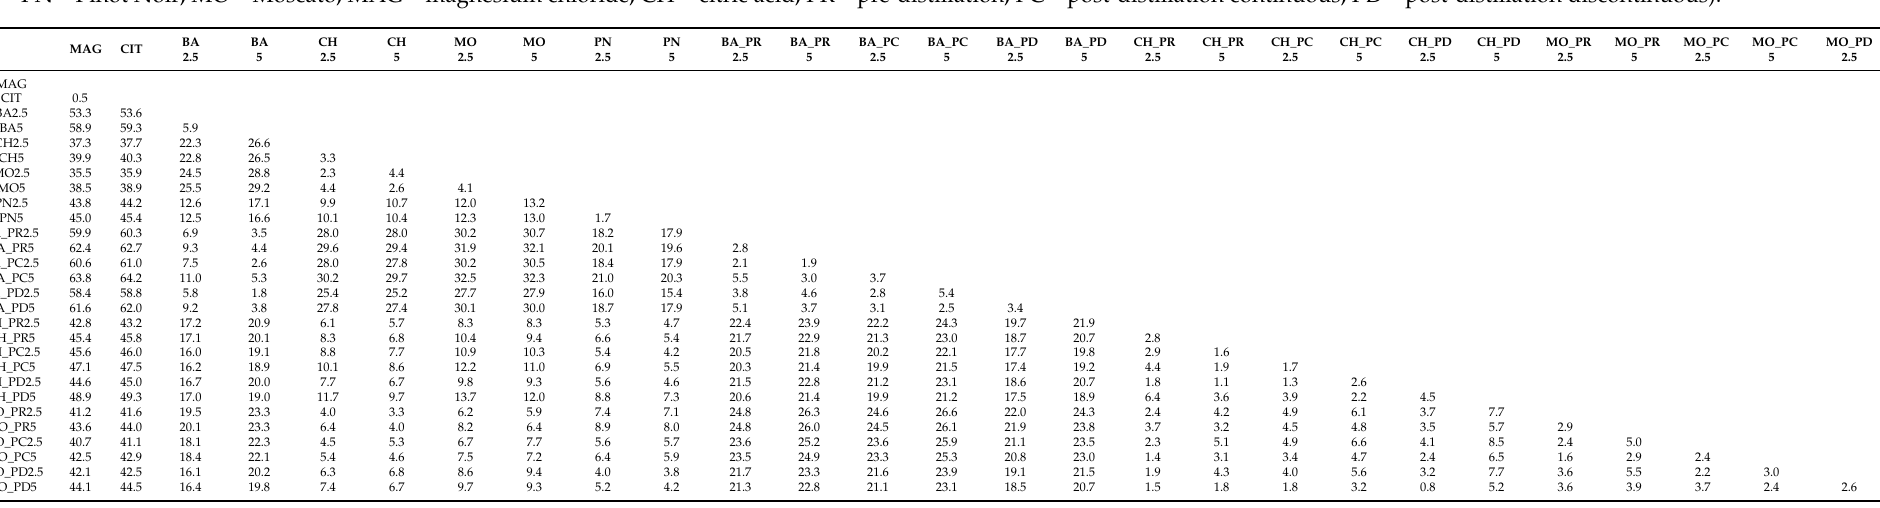
Table 3. Values of ∆ E calculated among the tofu samples obtained with the traditional and innovative coagulants at two concentrations (2.5% and 5%) (BA—Barbera; CH—Chardonnay; PN—Pinot Noir; MO—Moscato; MAG—magnesium chloride; CIT—citric acid; PR—pre-distillation; PC—post-distillation continuous; PD—post-distillation discontinuous). MAG